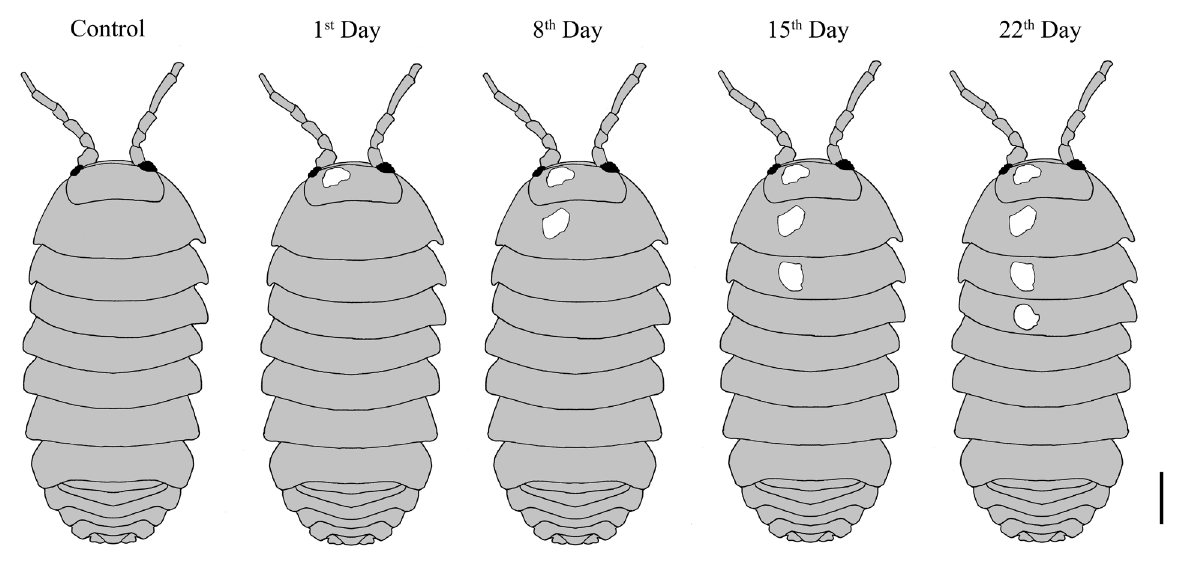
Figure 1. Woodlice ( Armadillidium vulgare ) external marking process during the 28 days of